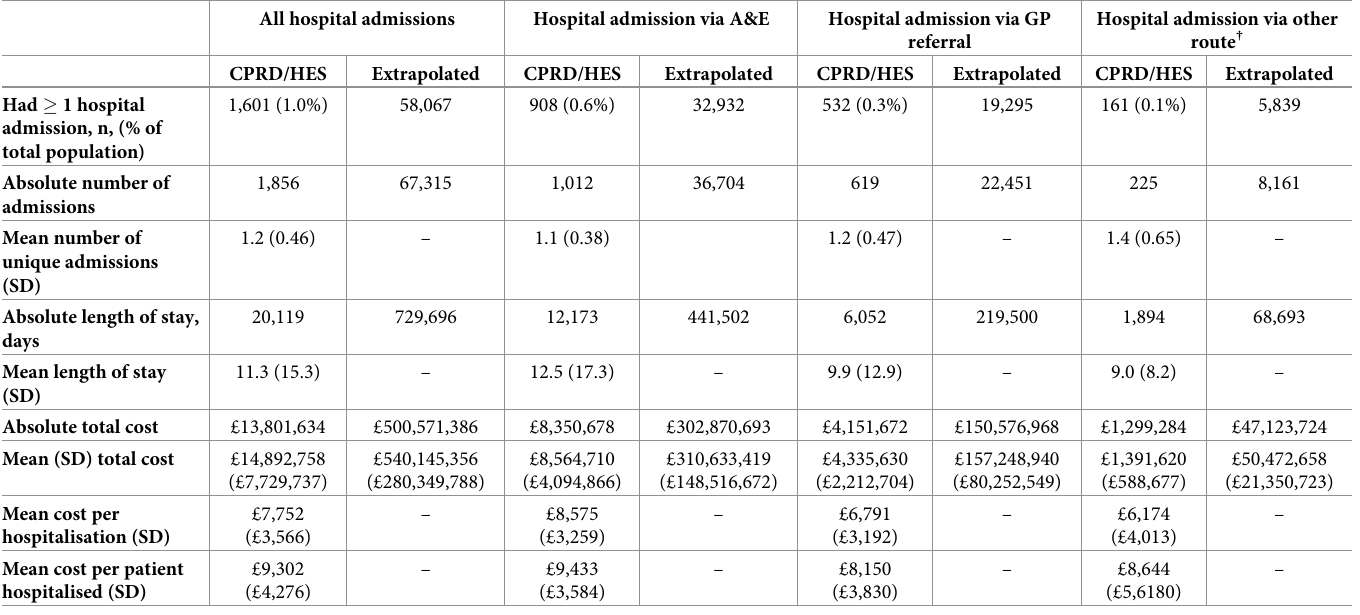
Table 2. Secondary care resource use and direct medical costs of acute respiratory illness during influenza seasons from 2001 to 2009 in the CPRD/HES population and extrapolated to the UK population.